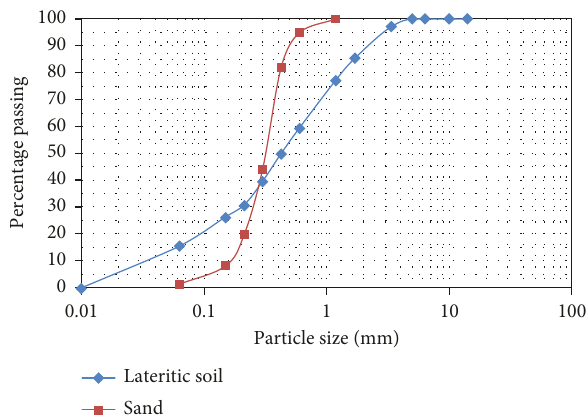
Figure 1: Particle size distribution of sand and lateritic soil in this study.